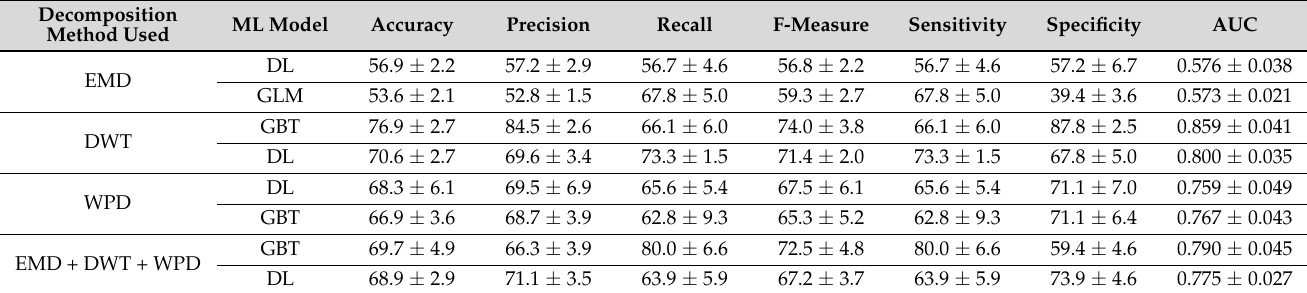
Table 4. Classification performance of the best two ML models after feeding all extracted features in each decomposition method individually and